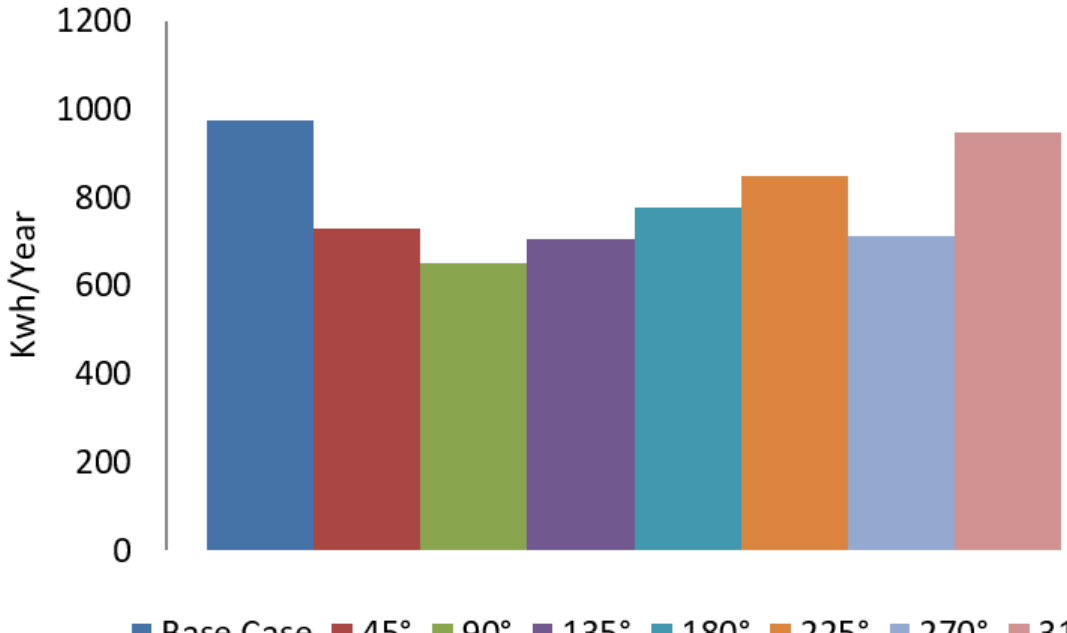
Figure 5. Energy consumption (cooling loads) to sustain thermal comfort for different